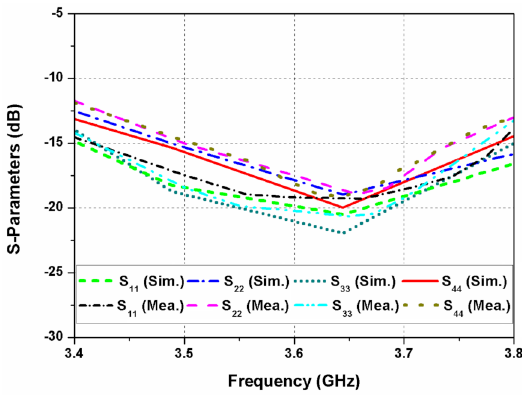
Figure 8. Reflection coefficients of the designed MIMO antenna.